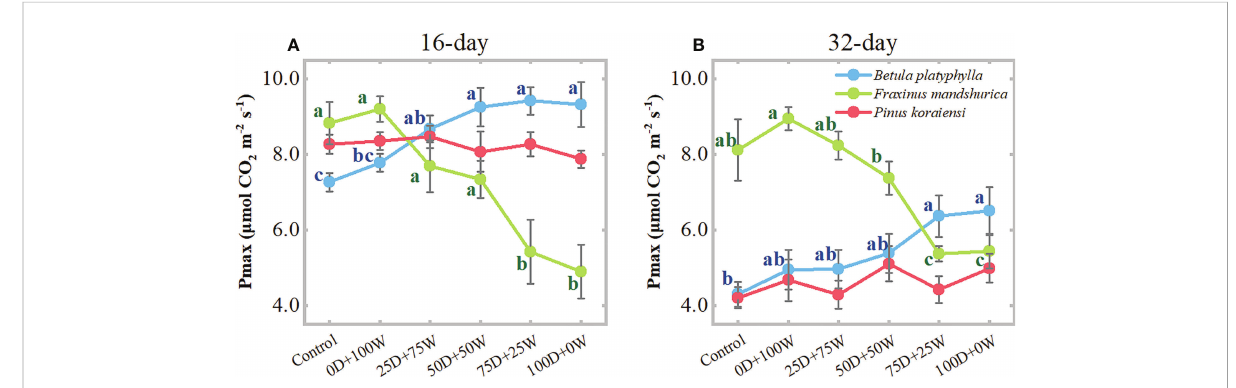
FIGURE 6 Relationships between light-saturated net photosynthesis rate (Pmax) and foliar Potassium (K) concentrations (A) , chlorophyll concentrations (B) in the three species. Within the same species, each symbol represents data from one N application treatment. N application treatments included a control (no application of N) and canopy N deposition with dry to wet ratios of 0:100, 25:75, 50:50, 75:25 and 100:0, respectively. Data were collected after 32 days of N application